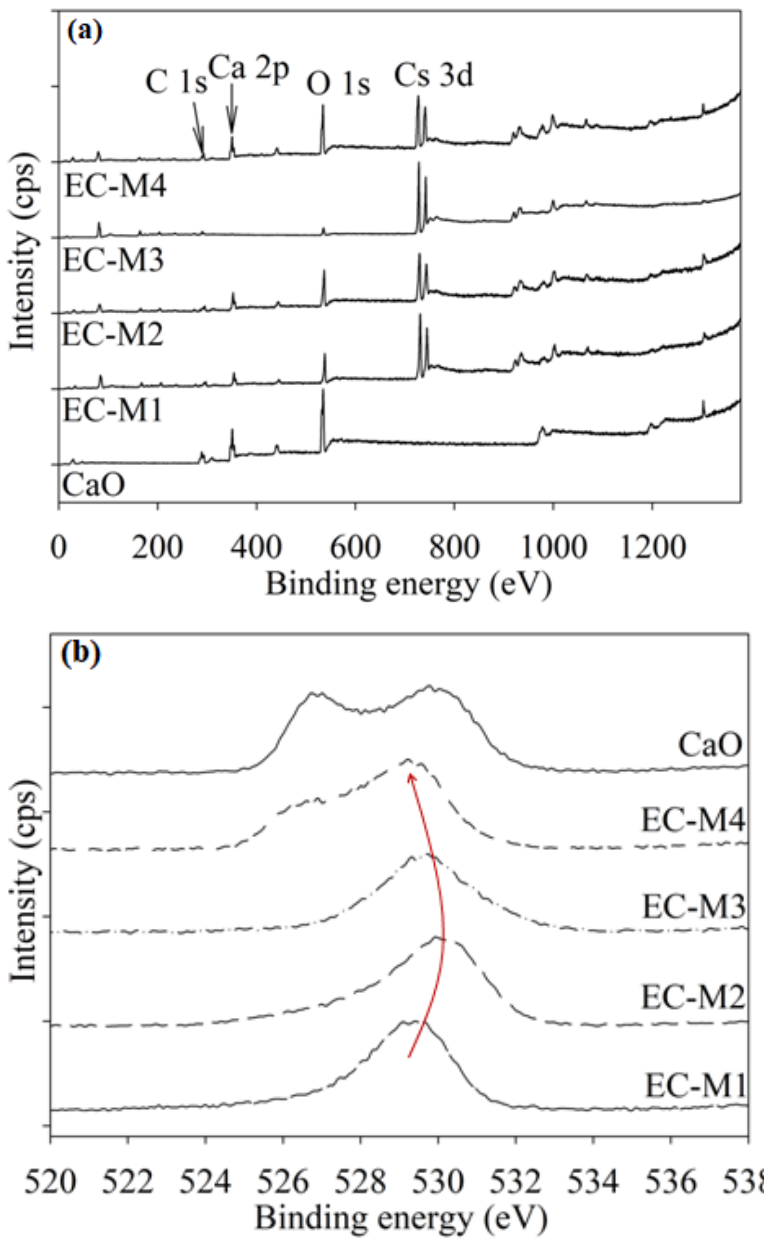
Figure 3. XPS spectra of ( a ) the survey spectra for CaO and CsO 2 -modified catalysts. ( b ) High- resolution O 1s peaks of the CaO and CsO 2 -modified catalysts. Table 3. Basicity